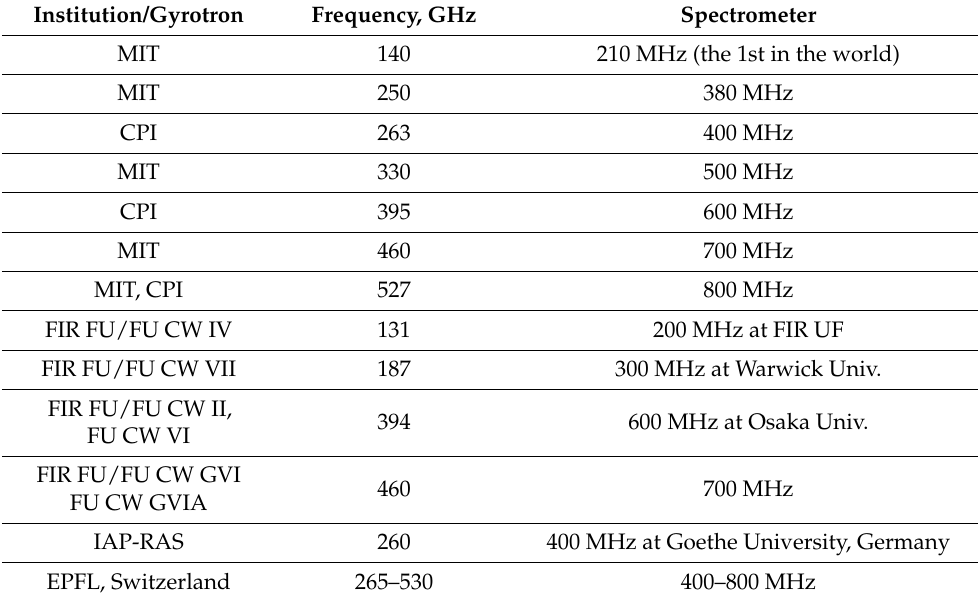
Table 1. Gyrotrons for DNP-NMR